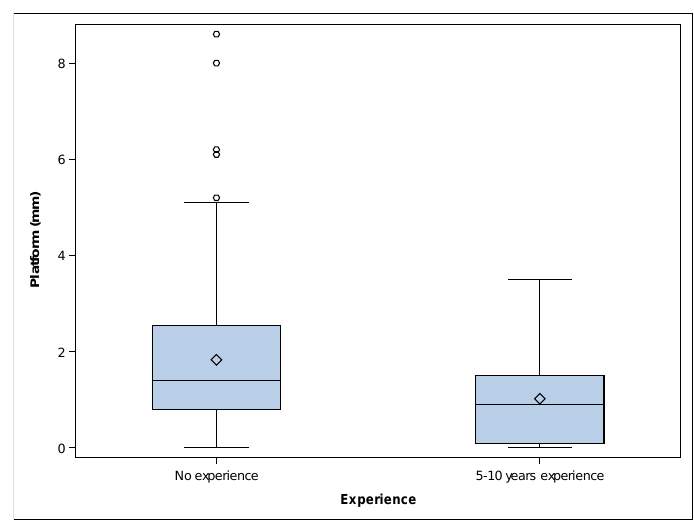
Figure 3. Box plots of platform deviations of the experimental groups. The horizontal line in each box represents the median value.